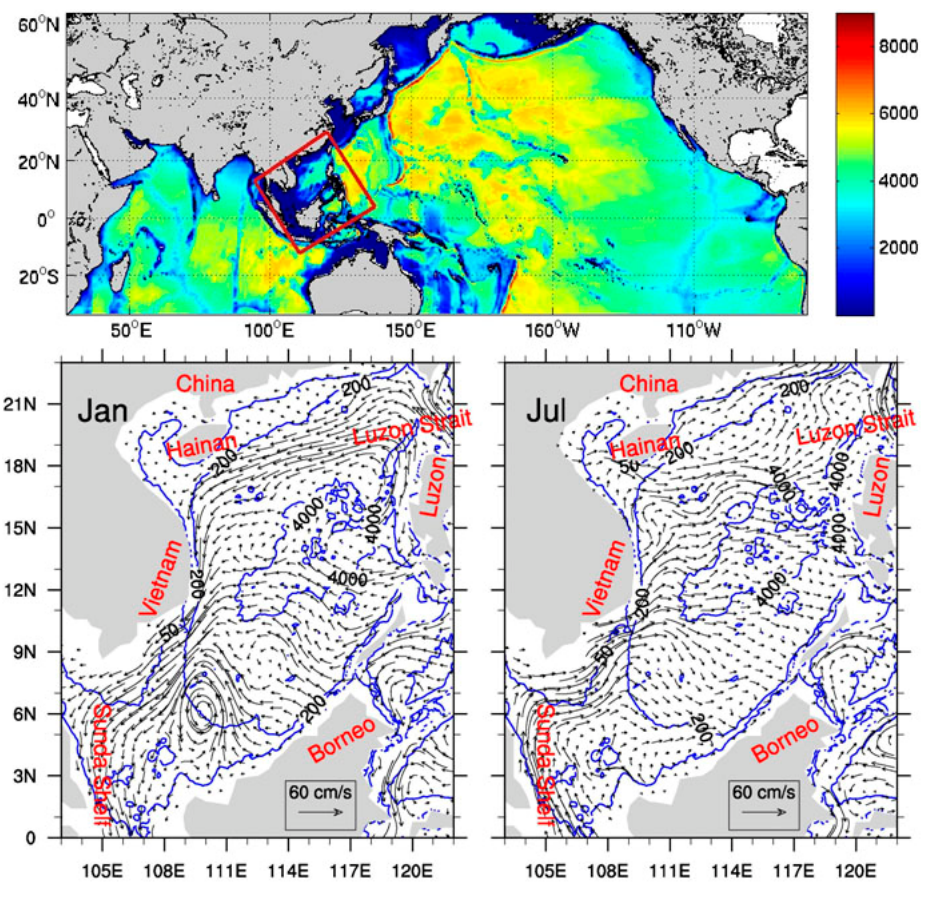
Fig. 1. Top: a two model nested system, where the outer model covers the most of the Indian and Pacific Oceans. Bathymetry is shown in colors. Bottom: Maps of the South China Sea and the mean surface currents simulated by the nested model during 1994–1995. The black arrows illustrate the simulated surface currents in January and in July, respectively. The blue contours indicate the 50, 200 and 4000 m isobaths.